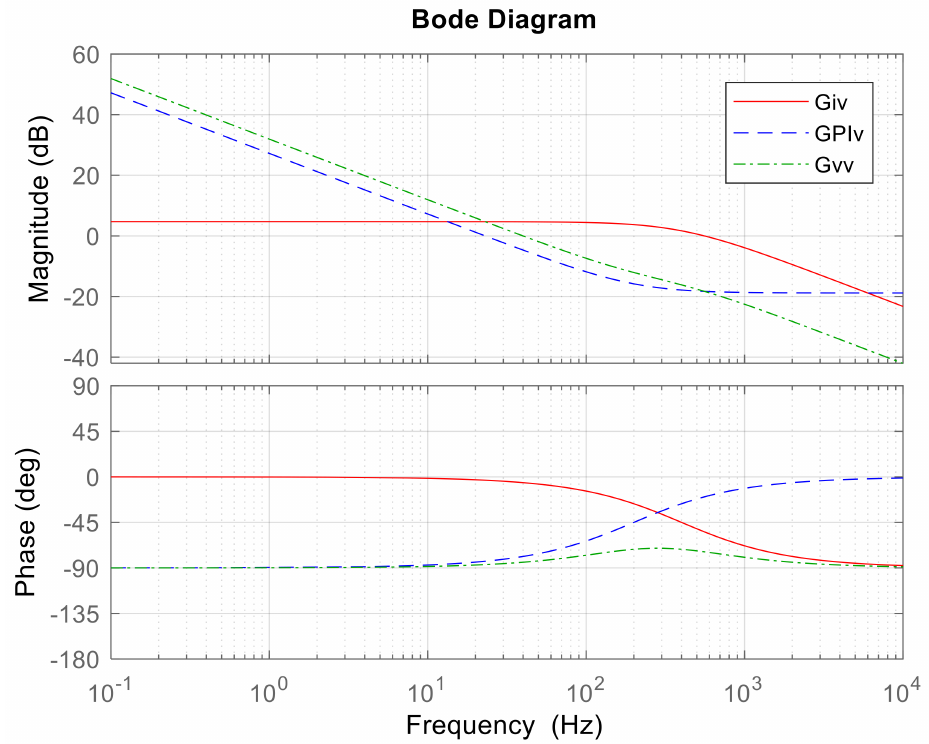
Figure A5. Bode plots of the outer-voltage–control-loop